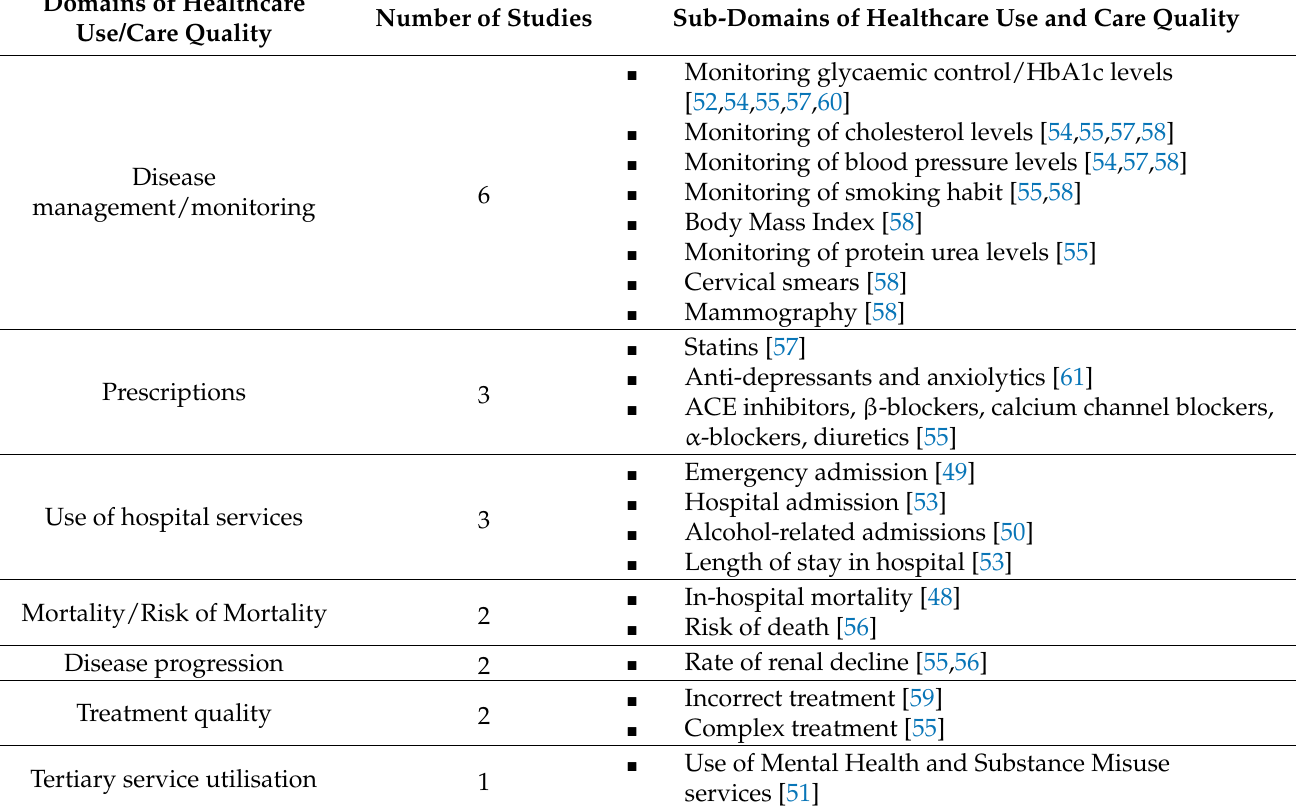
Table 1. Domains and sub-domains of healthcare use and care quality assessed in included